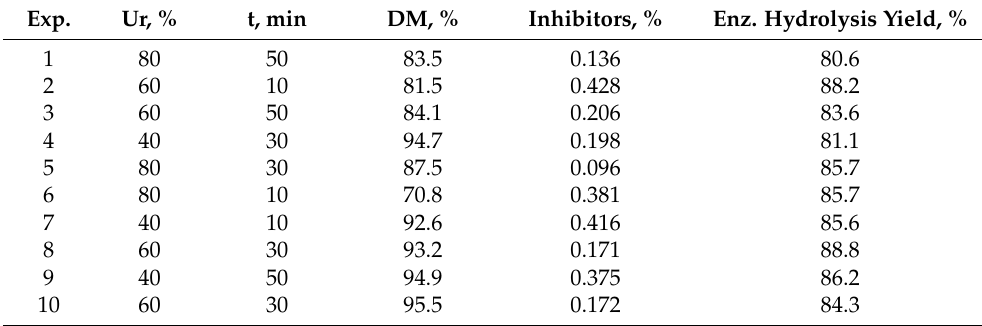
Table 5. Experimental a responses at different conditions.